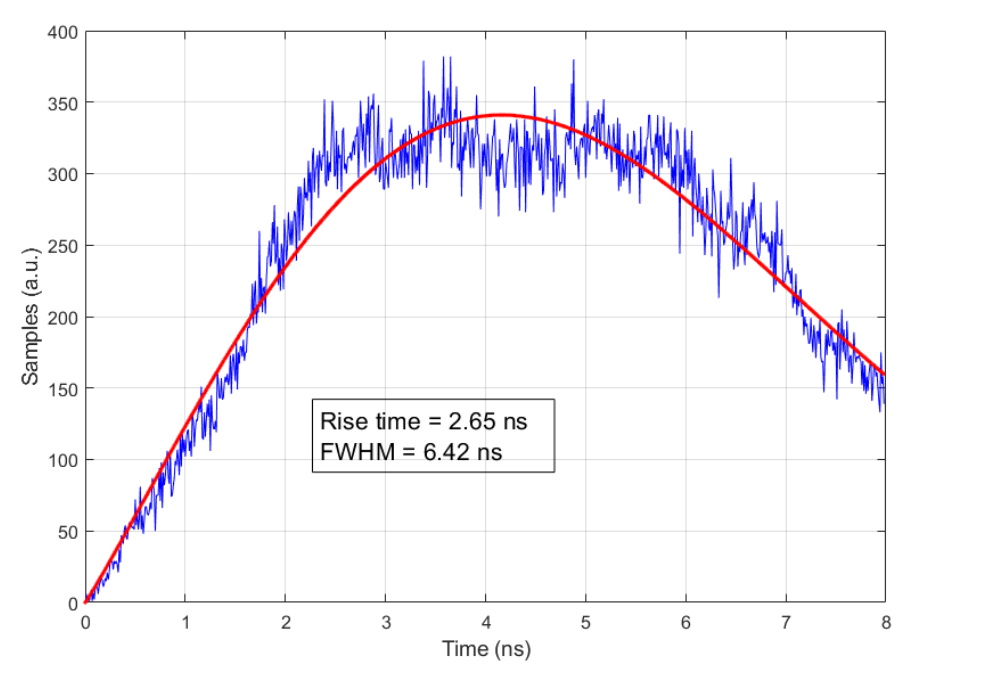
Figure 14. Pulse shape of NOPELED obtained using the technique of the photo-electron. NOPELED was operated at 1 kHz, and a voltage of 15 V. The histogram obtained has been fit to a Weibull function, obtaining a rise time of 2.65 ns and an FWHM of 6.42